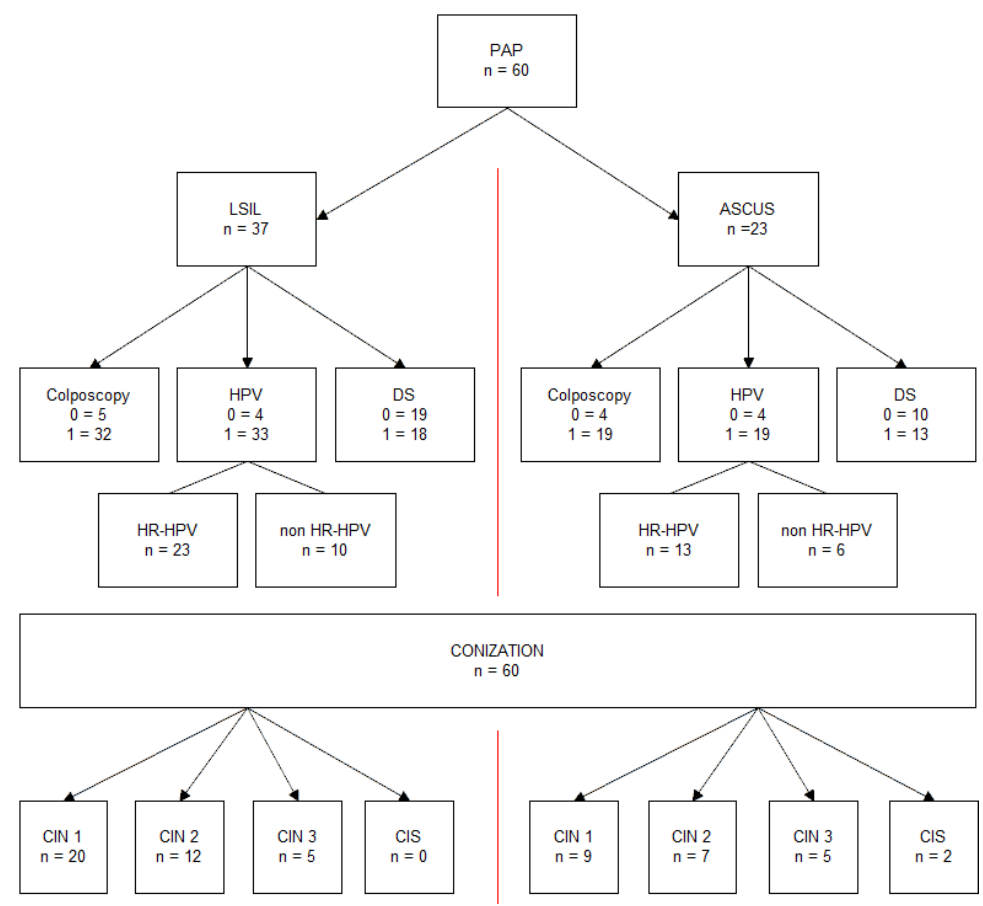
Figure 1. Study flow chart. The patients in the ASC-US and L-SIL groups were followed up for 12 months after LEEP. Abbreviations used: ASC-US: atypical squamous cells of undetermined significance; L-SIL: low-grade squamous intraepithelial lesion; LEEP: loop electrosurgical excision procedure; PAP: cervical cytology, Papanicolaou test; HPV: human papilloma virus; CIN: cervical intraepithelial neoplasia; HR-HPV: high-risk human papilloma virus; CIS: in situ carcinoma; conization: